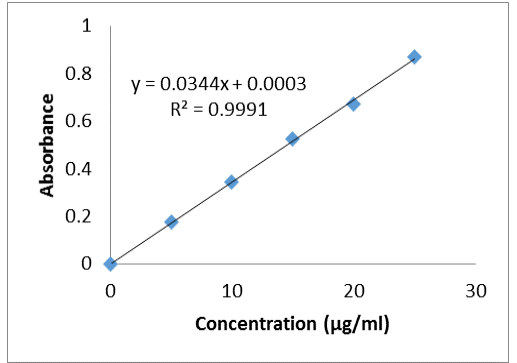
Figure 3. Calibration curve for raltegravir in distilled water Table 3. Powder flow properties of (trial 1 –trial 10)